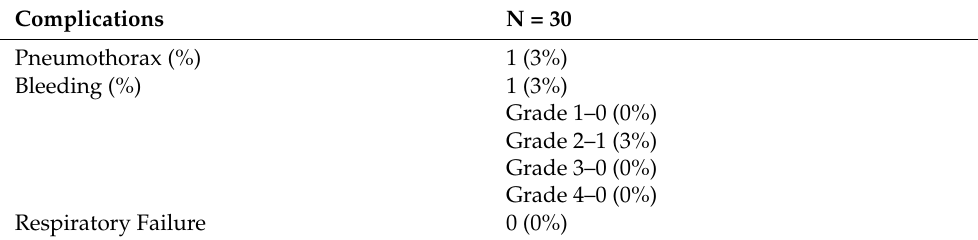
Table 3. Procedural